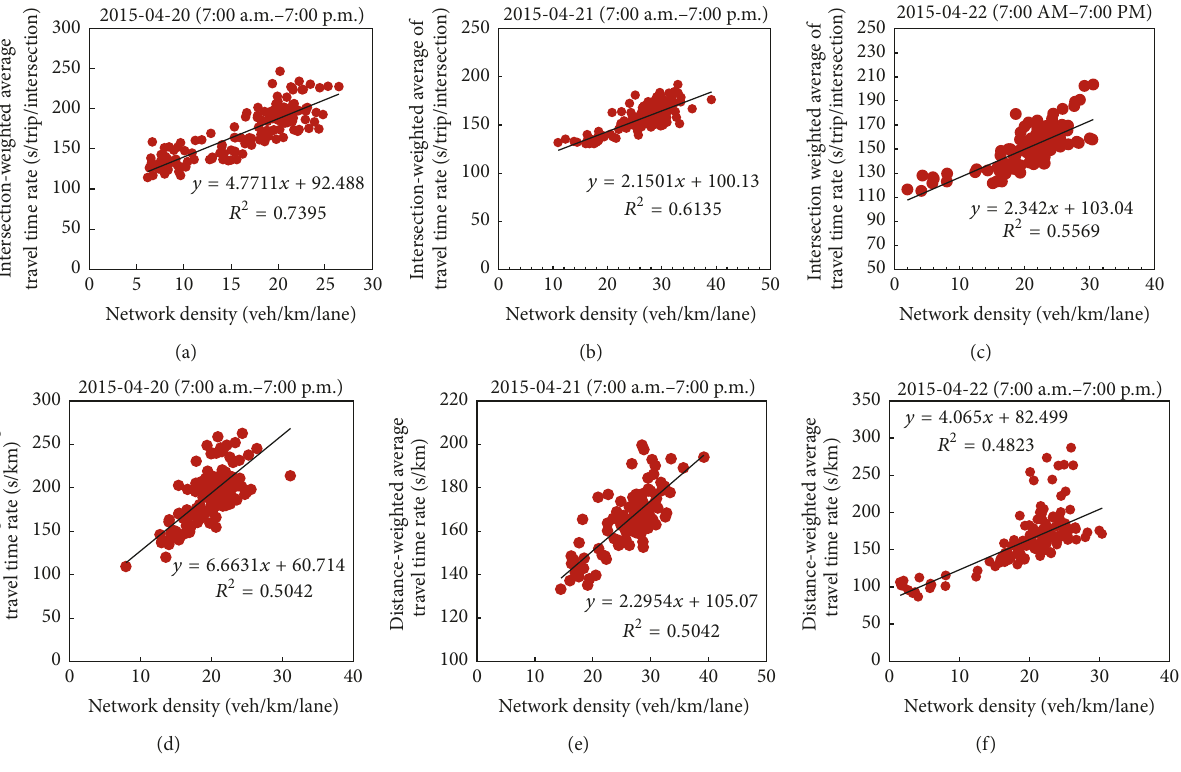
Figure 7: Weighted average travel time rate versus network density.